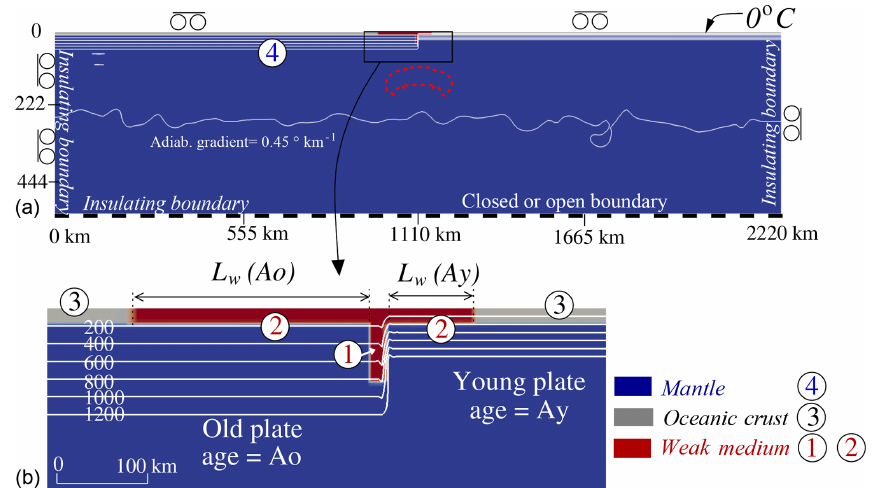
Figure 2. (a) Boundary conditions, initial thermal state, and material distribution at simulation start. One white isotherm every 200 ◦ C. If the box bottom is open, a vertical resistance against flow is imposed to simulate a viscosity jump approximately 10 times higher below the simulation box (Ribe and Christensen, 1994; Arcay, 2012). The red dotted line represents the hot thermal anomaly ( (cid:49)T = + 250 ◦ C) imposed in some experiments. (b) Close-up on the TF structure. L w is the width at the surface of the younger plate and of the older plate (aged of A y and of A o Myr, respectively) over which the oceanic crust is assumed to have been altered and weakened by the TF activity. The meaning of labels 1 to 4 is given in Sect.